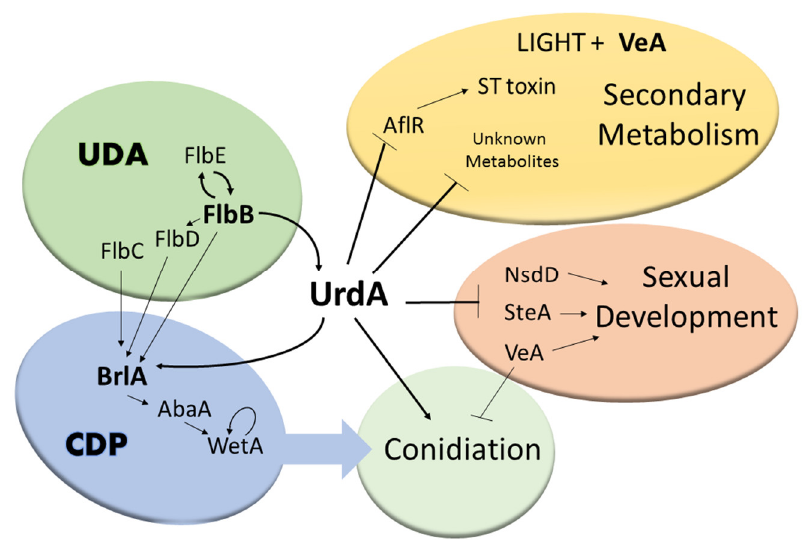
Figure 10. Model for UrdA activity. The upstream developmental activators (UDA) signaling pathway controls UrdA [27], and UrdA controls the central developmental pathway (CDP) pathway and conidiation (in both veA1 [27] and in veA wild-type background, as shown in the present study). UrdA also negatively affects NsdD, SteA and VeA, inhibiting sexual development. In addition, UrdA represses the production of ST (by negatively influencing AflR) and of other known secondary metabolites. Protein codes are used for